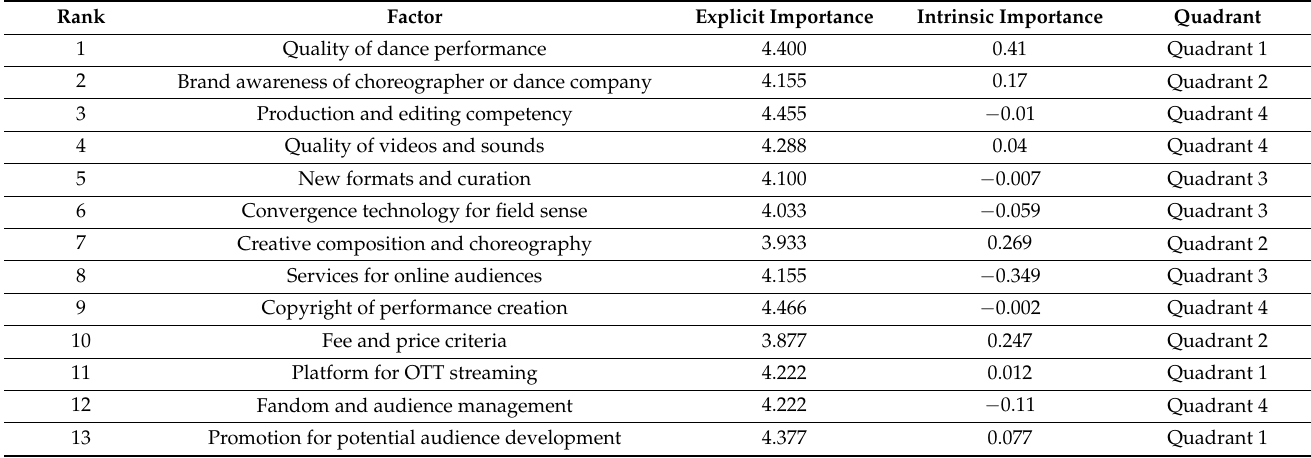
Table 2. Results of revised